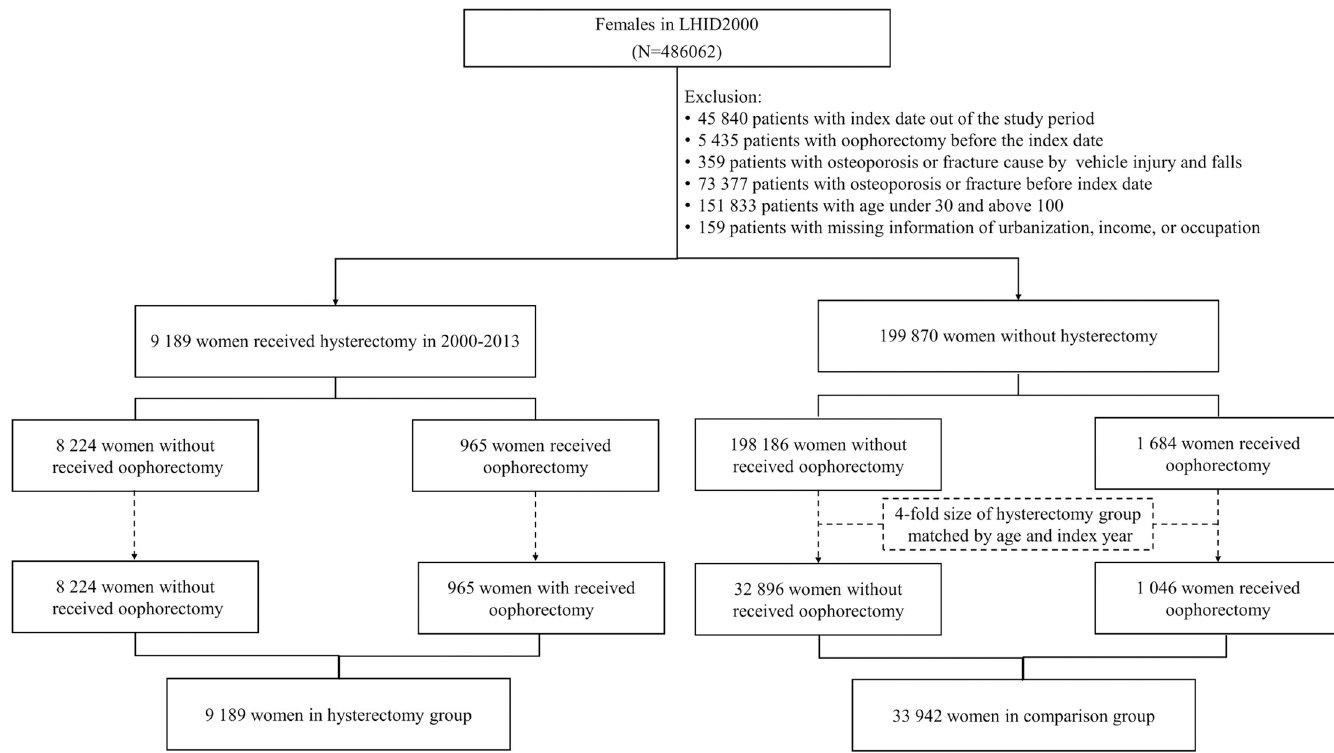
Fig 1. Study flow chart: The participants population enrolled from the National Health Insurance Research